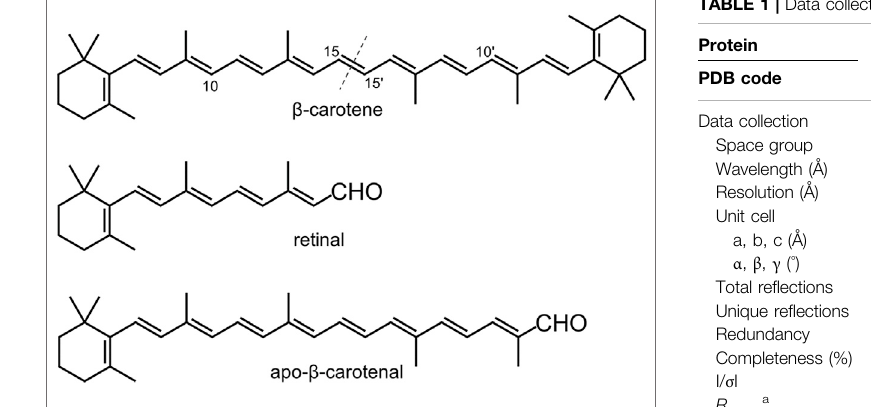
FIGURE 1 | Chemical structures of β -carotene, retinal, and apo- β - carotenal. The dashed line indicates the symmetric cleavage site. Apo- β - carotenal is used for enzymatic activity test.